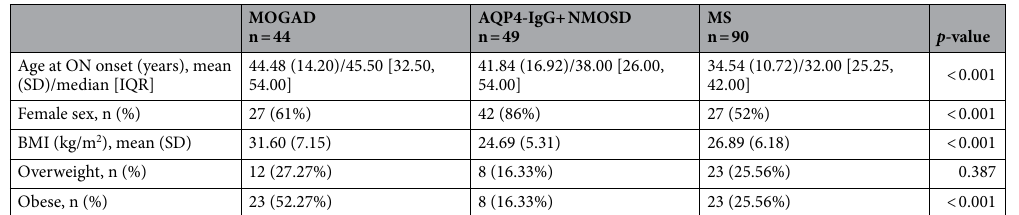
Table 1. Demographic characteristics of patients with first-ever acute optic neuritis (ON) stratified by etiology. MOGAD, myelin oligodendrocyte glycoprotein antibody-associated disease; AQP4-IgG+ NMOSD,